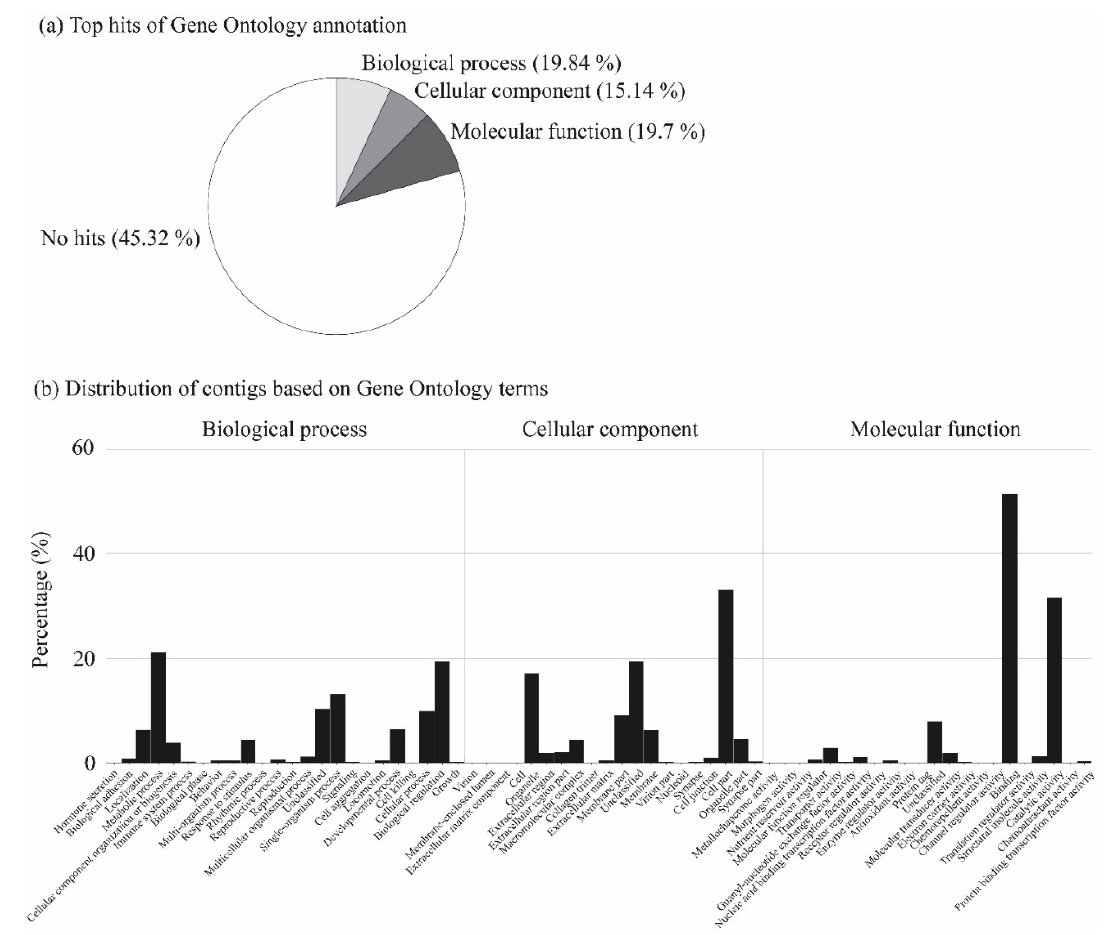
Figure 2. Classification of contigs derived from BLASTX. ( a ) Top hits of the Gene Ontology annotation showed that biological process, cellular component, and molecular function were the three top BLAST hits. The percentage of each category compared with the total number of contigs is provided in brackets. ( b ) Distribution of contigs based on the Gene Ontology terms provides a detailed percentage of the contigs annotated to each mechanism.